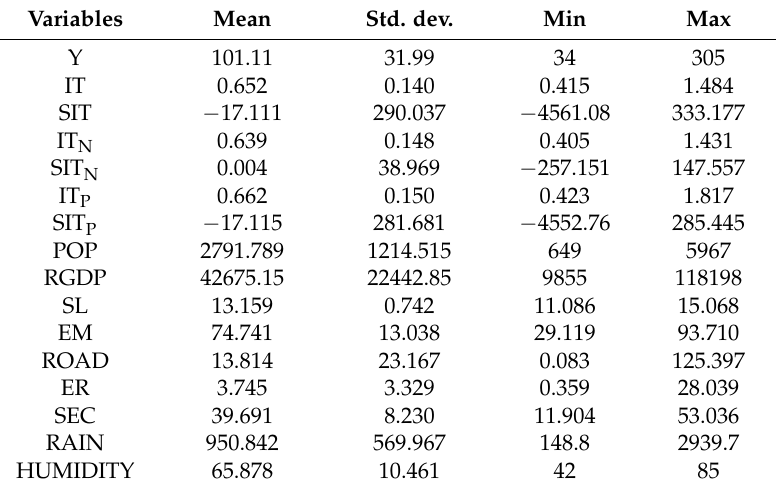
Table 3. Descriptive statistics for the